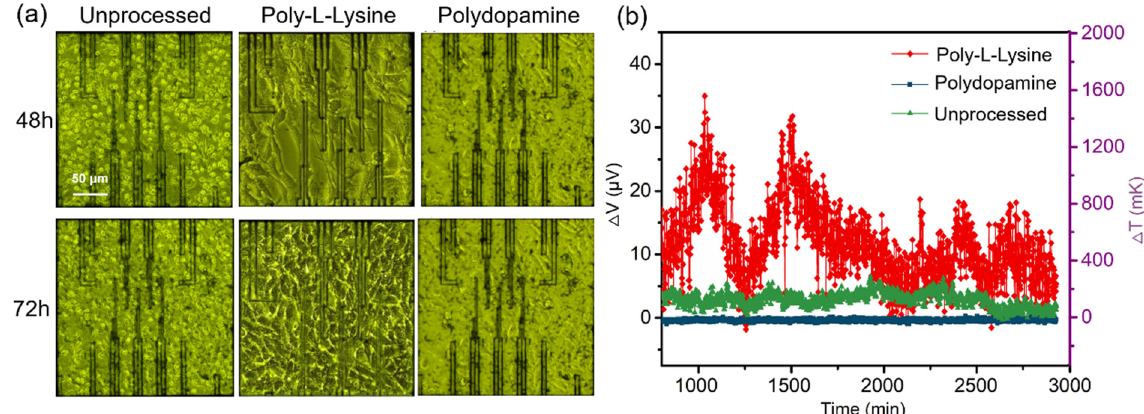
Figure 2. Effects of surface modifications of the chips. ( a ) Photos of the 48- and 72-h morphologies of HeLa cells on chips with different surface treatments. ( b ) Cell-temperature data collected from the unprocessed chip and from chips with poly-l-lysine and polydopamine modifications.